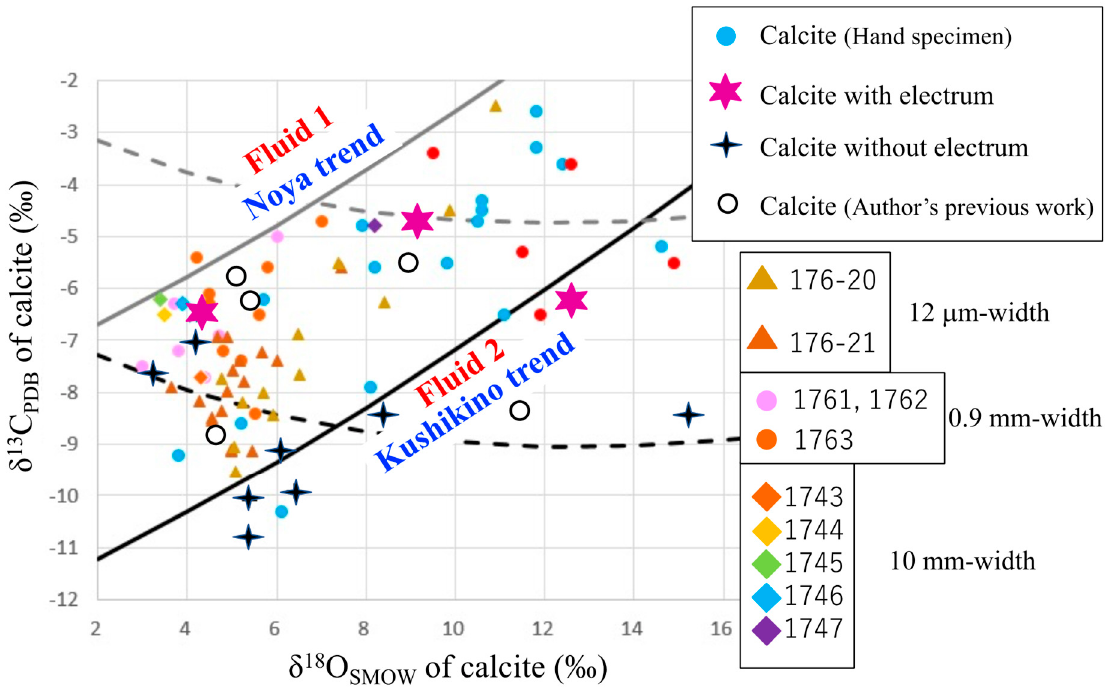
Figure 11. The δ 13 C and δ 18 O values of calcite from the Hishikari deposit. Blue solid circles indicate isotope data of calcite from hand specimens. The data from the 10 mm-width, 0.9 mm-width, and 12 µ m-width samples are represented by each symbol. Isotope data of calcite with/without electrum (purple star and black cross, respectively) are from [21], and data (open circles) from [19] are shown. The equilibrium fractionation trends of calcite for the Noya and Kushikino deposits are also shown.